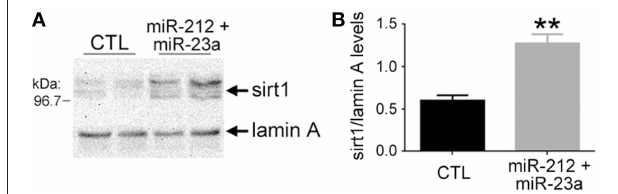
FIGURE 4 | Experimental down-regulation of miR-212 and miR-23a increases sirt1 protein expression. Human hNT neuronotypic cells were co-transfected with small inhibitors of miR-212 and 23a or scrambled negative controls (CTL). Given the co-localization of miR-23a and sirt1 in the nucleus, cells were harvested 36h following transfection with the miRNA inhibitors or controls and nuclear fractions were immunoblotted for detection of sirt1. (A) A representative western shows that miR-212/23a co-repression resulted in an increase in sirt1 immunoreactivity. (B) Quantitative analysis revealed that sirt1 levels were significantly increased by ∼ 100% in miR-212/23a inhibitor-transfected cells compared to CTL-transfected cells. n = 6 /group; ** p < 0.01 via Student’s unpaired test (two-tailed).